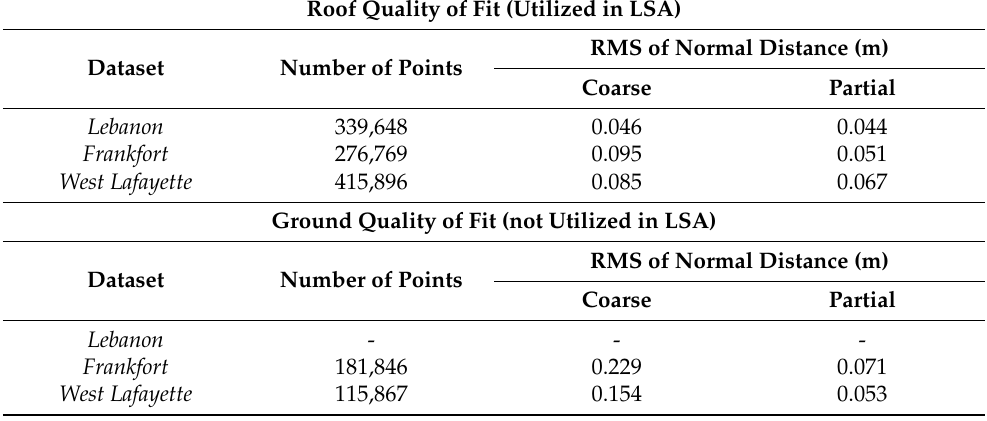
Table 3. RMS of the fitting error for the roof and ground features following the coarse/partial fine